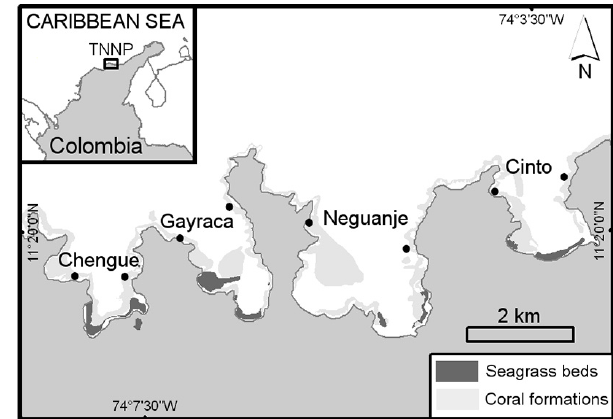
Figure 1. Bays of Tayrona National Natural Park (TNNP). Dis- played are Chengue, Gayraca, Neguanje and Cinto and the sam- pling locations at the western (water-current-exposed sites) and the eastern (water-current-sheltered sites) flanks of each bay. Source: Invemar